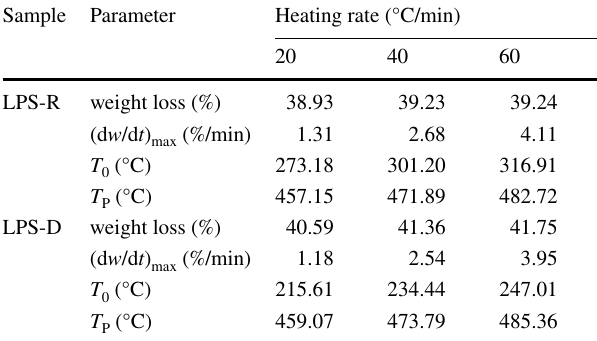
Table 7 Pyrolysis characteristic parameters of LPS-R and LPS-D Sample Parameter Heating rate